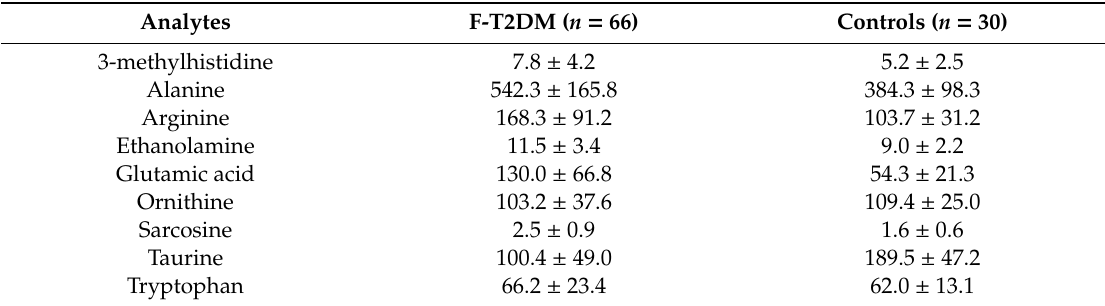
Table 2. Serum concentrations of discriminant biomolecules as resulted from partial least squares-discriminant